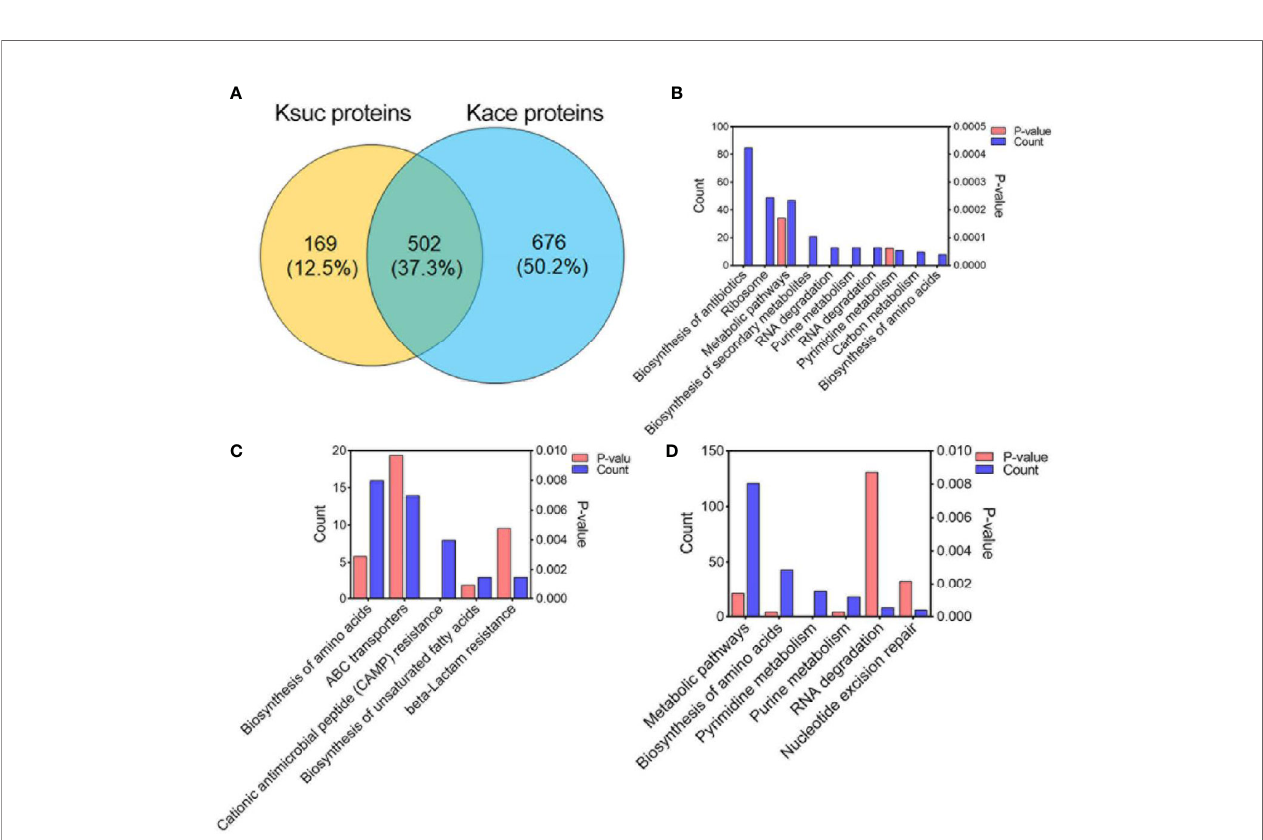
FIGURE 6 | Comparison of succinylated and acetylated proteins in V. alginolyticus . (A) Overlap between succinylated and acetylated proteins in V. alginolyticus . (B – D) KEGG pathway enrichment analysis of the overlapped proteins, speci fi c succinylated modi fi ed proteins, and speci fi c acetylated modi fi ed proteins.